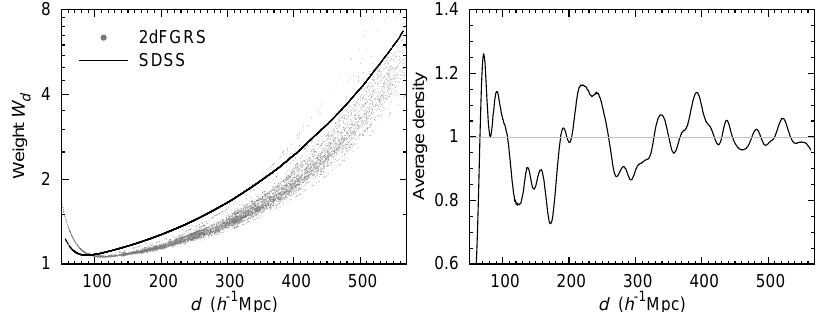
Fig. 2. Left panel : the weight factor W d at different distances for the 2dFGRS (grey dots) and SDSS (black line) samples. Right panel : the average global density in thin concentric shells, in units of the global mean density for the SDSS